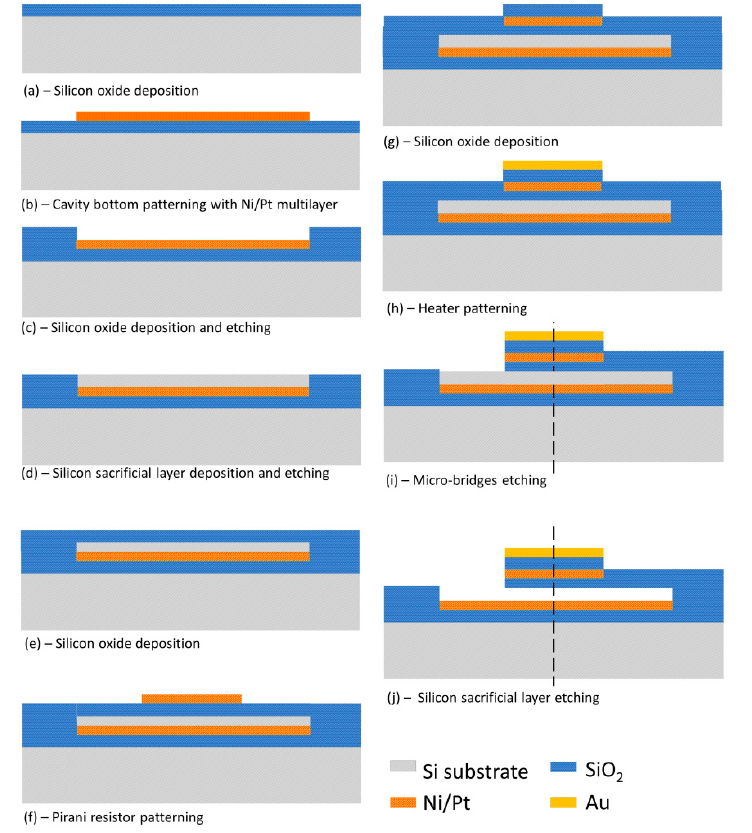
Figure 3. Fabrication